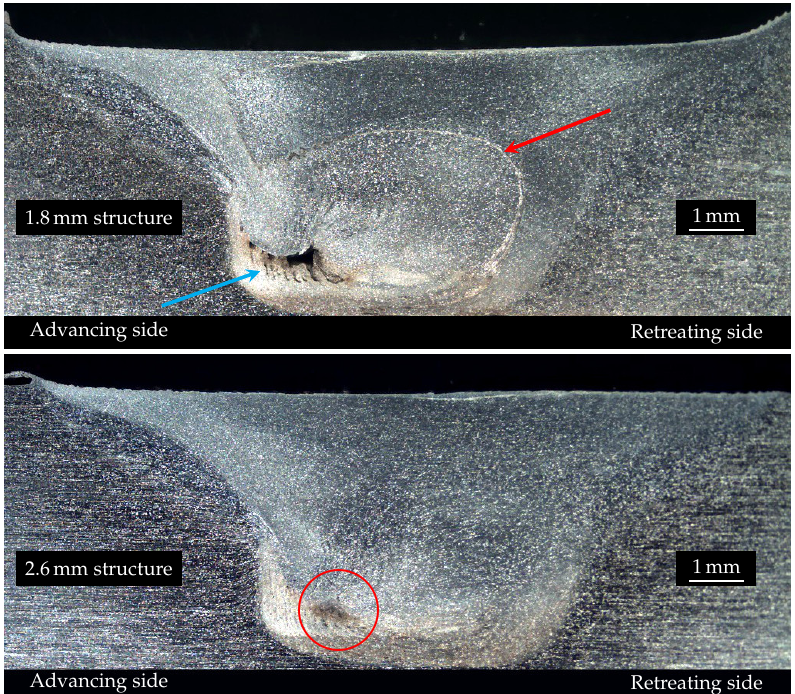
Figure 13. Etched cross sections of the welding tests carried out for validation with material flow representation at the (former) neuralgic stagnation point. 1.8mm ( top ) and 2.6mm ( bottom ) structure width.